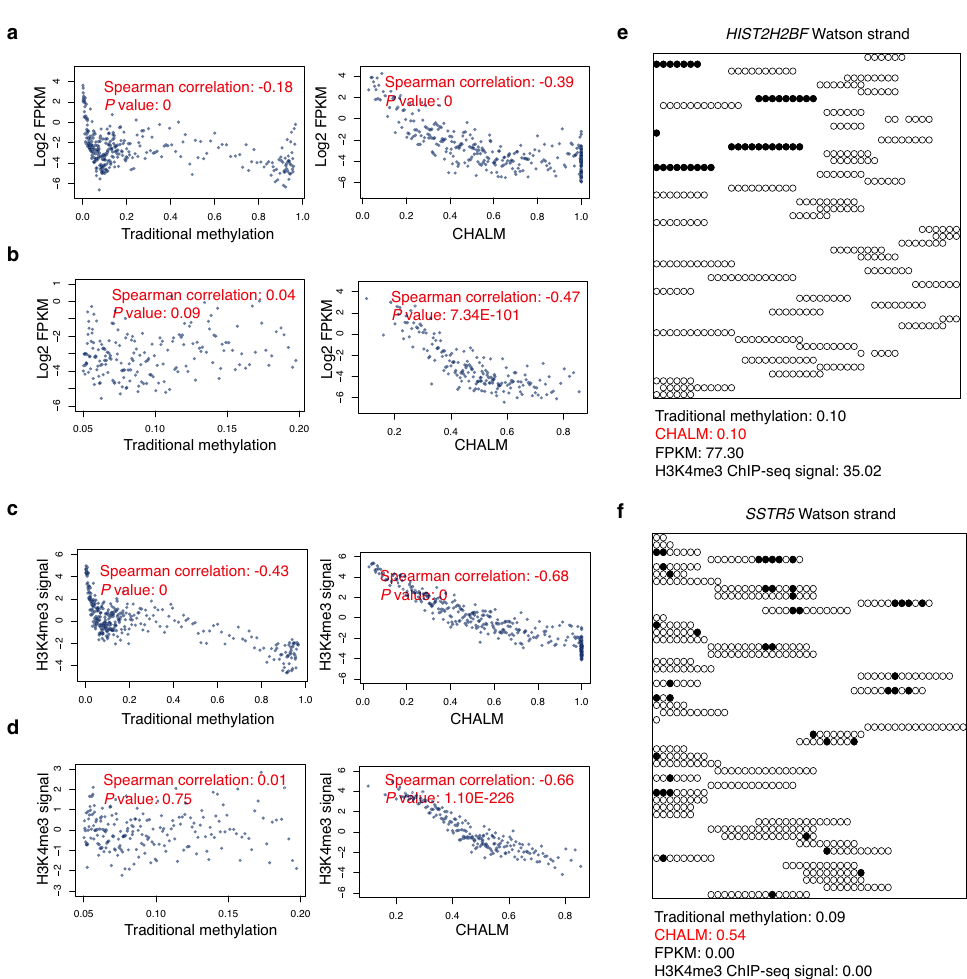
Fig. 2 The CHALM method better predicts gene expression. a Scatter plots show the correlation between gene expression and methylation level calculated using both methods. Balanced promoter CGIs (Methods section) of CD3 primary cells are used. Each data point represents the average value of 10 promoter CGIs, and the Spearman correlation is calculated based on original data for each promoter CGI. Comparison of correlation (between the traditional method and CHALM) P values calculated by permutation (Methods section): <1 × 10 − 4 . b Similar to a but focusing on low-methylation genes. Comparison of correlation permutation P values: <1 × 10 − 4 . c Scatter plots show the correlation between H3K4me3 ChIP-seq intensity and methylation level calculated by the traditional and CHALM methods. Balanced promoter CGIs are used. Comparison of correlation permutation P values: <1 × 10 − 4 . d Similar to c but focusing on low-methylation genes. Comparison of correlation permutation P values: <1 × 10 − 4 . e , f Methylation status of reads mapped to the promoter CGI of HIST2H2BF or SSTR5 , respectively. Black circles: mCpG; white circles: